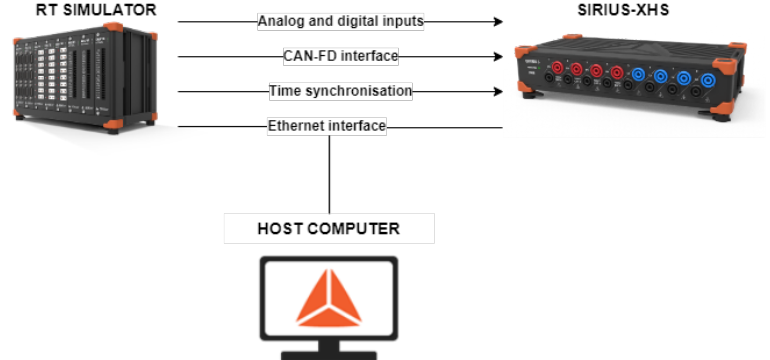
Figure 12. Configuration of measurement system under